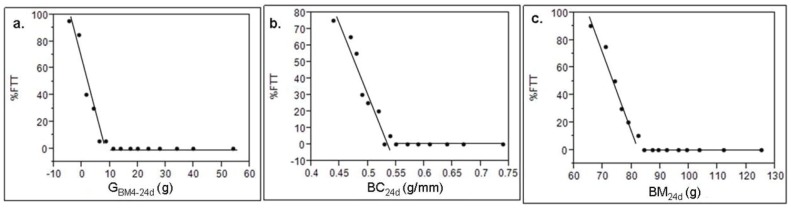
Probability of avoiding FTT and surviving to 300 days for hatchling C. porosus (N = 300) in relation to a) GBM4-24d, b) BC24d, and c) BM24d.Points are means for progress intervals (N = 20).